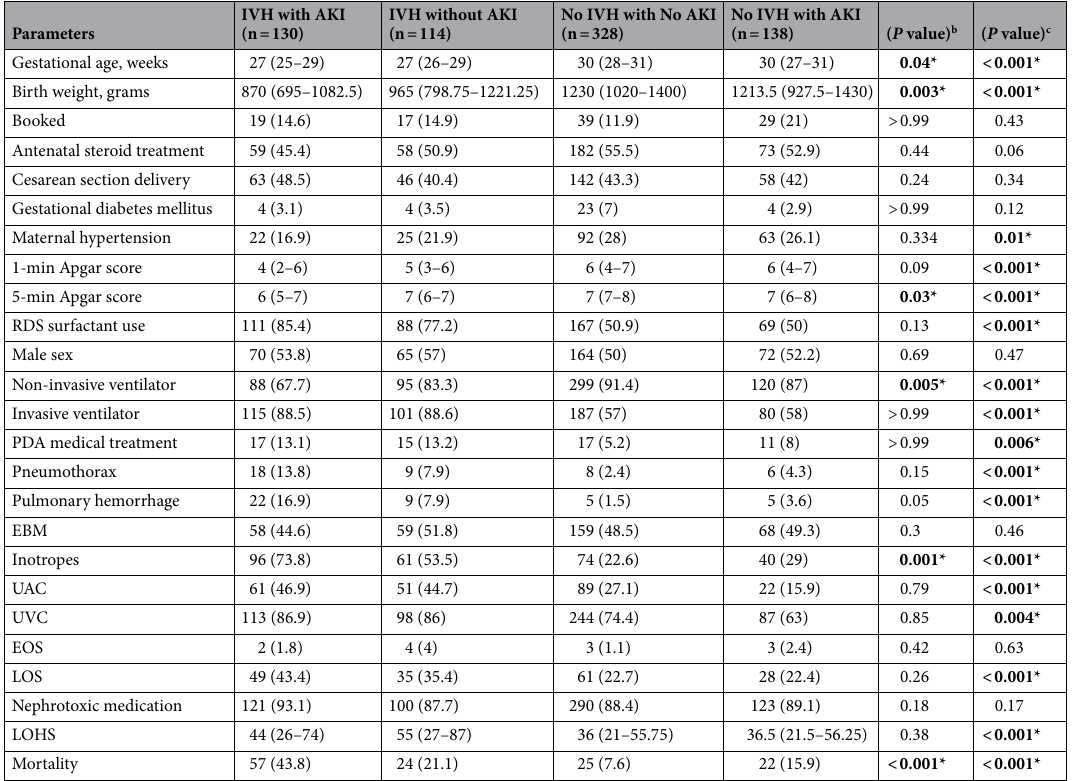
Table 1. Comparison of demographic, clinical, and maternal characteristics among infants with and without IVH and/or AKI (n = 710). Data are presented as median (IQR), or number (%), as appropriate. Abbreviations: IVH intraventricular hemorrhage, AKI acute kidney injury, GDM gestational diabetes mellitus, RDS respiratory distress syndrome, PDA patent ductus arteriosus, EBM expressed breast milk, UAC umbilical arterial catheter, UVC umbilical venous catheter, EOS early-onset sepsis, LOS late-onset sepsis, LOHS length of hospital stay. *Statistically significant at 5% level. Bold values indicate all values less than 0.05 are significant. a Nephrotoxic medication: Acyclovir, Amphotericin B, Aminoglycosides, Vancomycin. b Comparison between IVH with AKI versus IVH without AKI. c Comparison between IVH with AKI versus no IVH with no AKI.